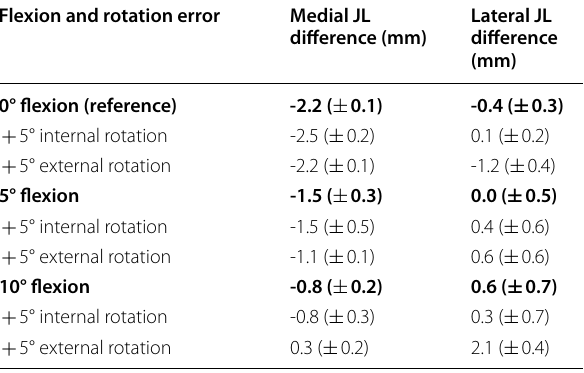
Table 3 Radiographic measurements of medial and lateral JL difference with flexion and rotation error